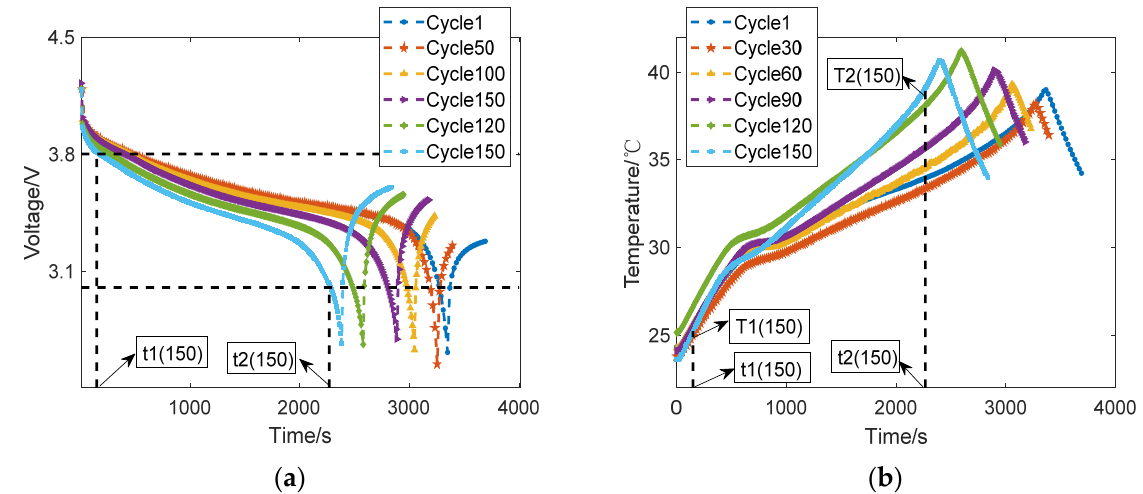
Figure 2. Representations of the feature selection. ( a ) Representation of the feature selection in voltage curve; ( b ) Repre- sentation of the feature selection in temperature curve.